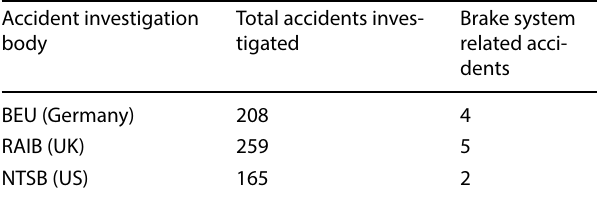
Table 2 Railway accidents between 2007 and 2020 Accident investigation